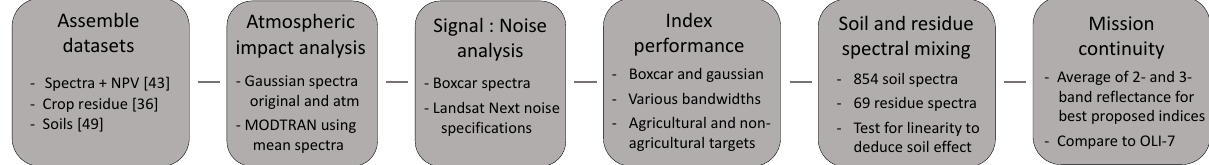
Figure 2. Workflow, including data compilation, atmospheric and signal-to-noise assessment, evaluation of index performance, background soil effects, and determination of mission continuity for proposed bandwidths and band centers associated with the top-performing indices.